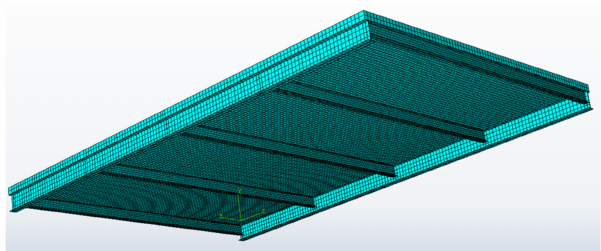
Figure 3. Meshed Composite Steel-Concrete Floor System.